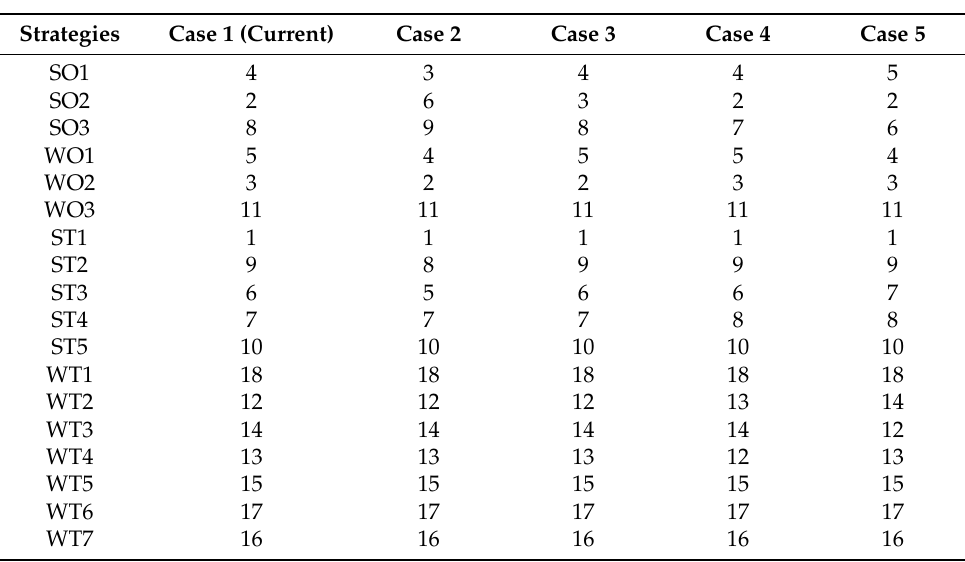
Table 5. Results of the sensitivity